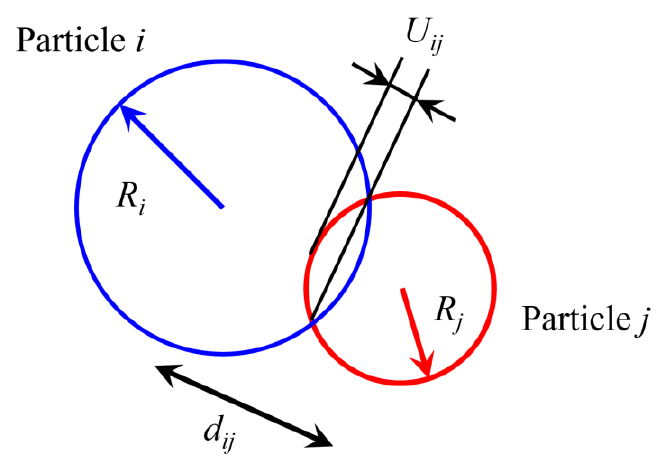
Figure 1. Overlap between particles.